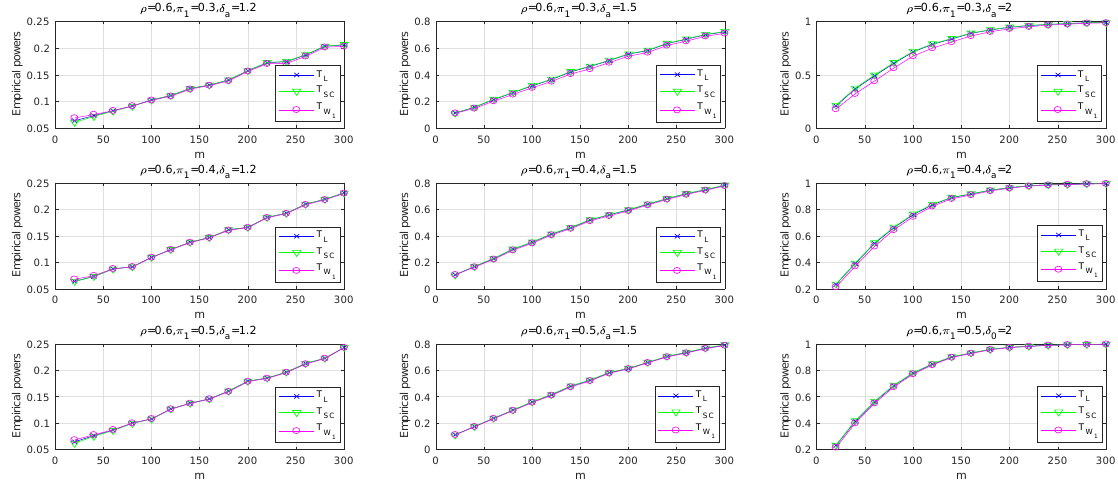
Figure 2. Curves of empirical powers under H 0 : δ 0 =